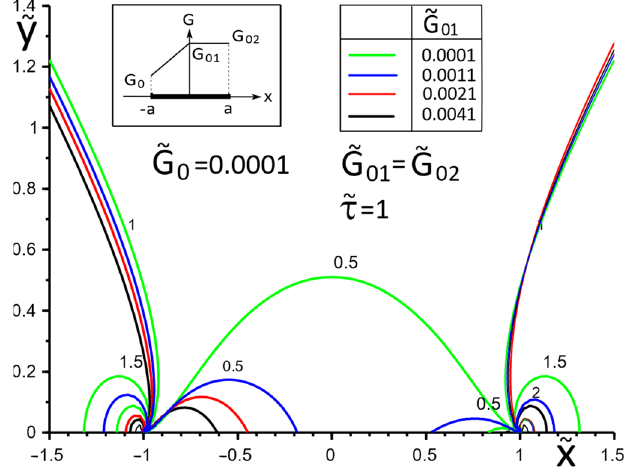
Figure 11. Stress distribution in the matrix at the vicinity of the inclusion with the piecewise linear distribution of material stiffness.